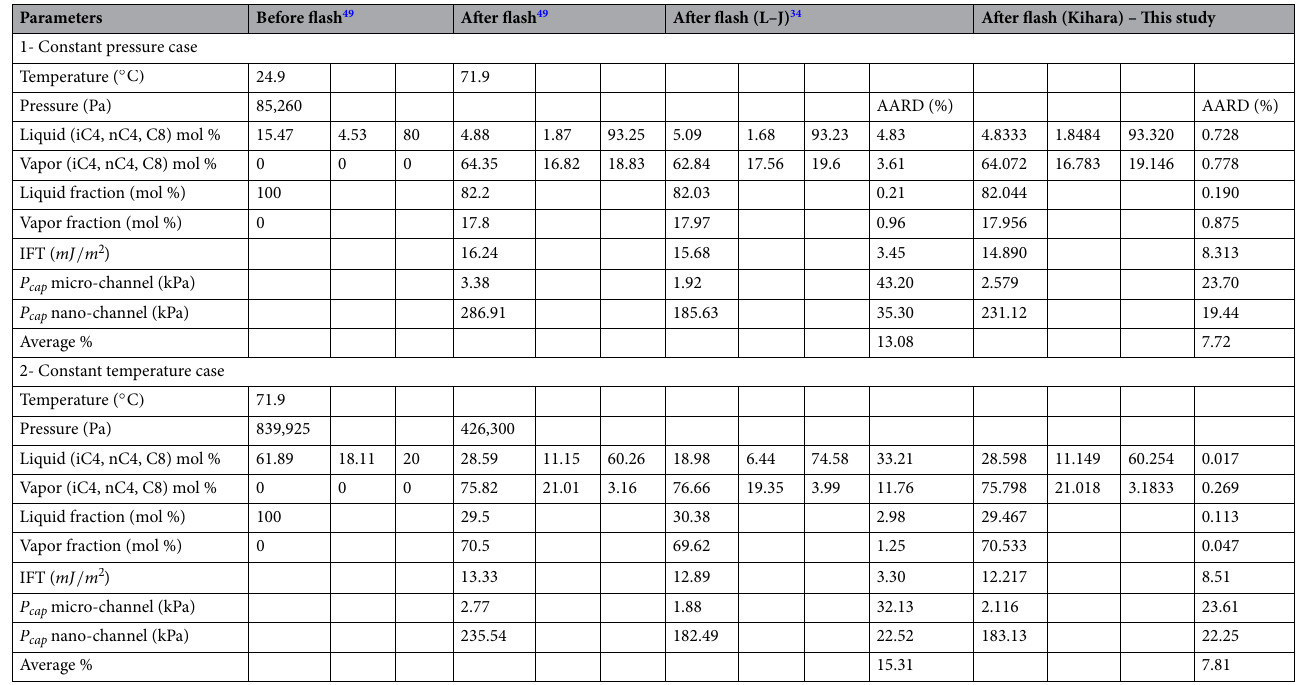
Table 8. Experimental VLE properties of a ternary system 49 compared to the reported calculations of L-J model 34 and this model proposed in this study for 1-Constant Pressure Case and 2- Constant Temperature Case in 10 µ m and 100 nm